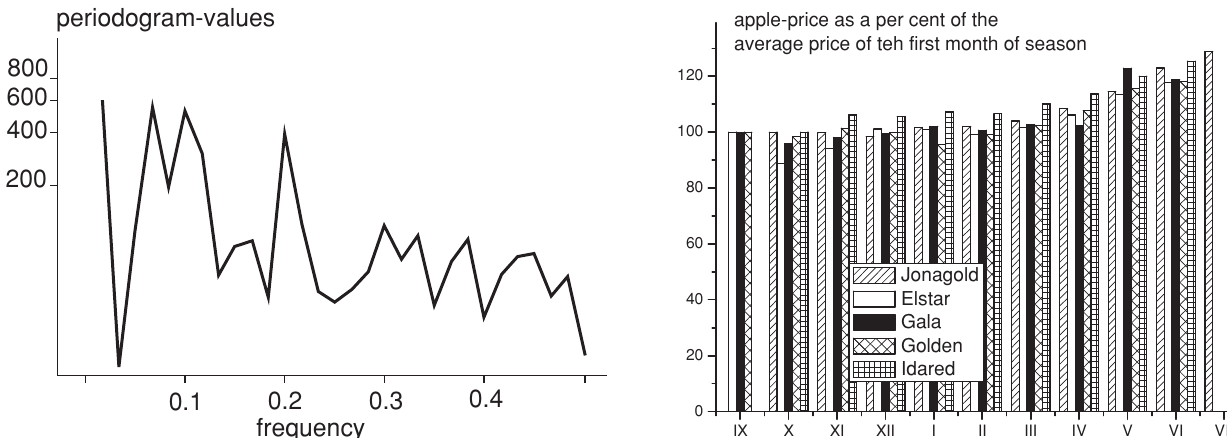
Figure 6. Change of apple-prices during the seasons in Germany for different